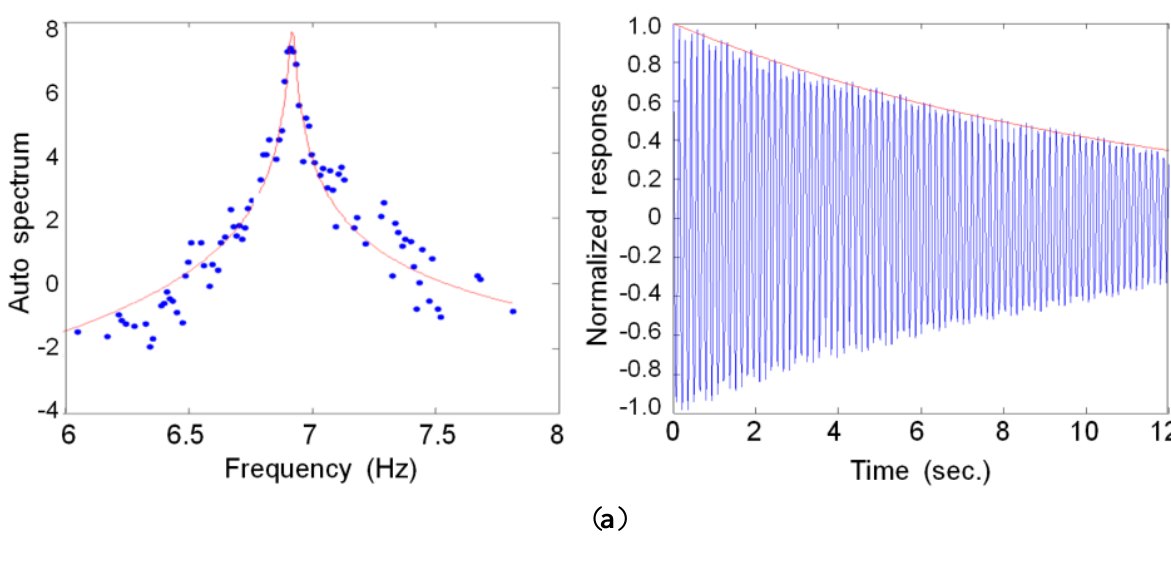
Figure 9. Auto spectrum and free vibration wave for extracting the damping value (1st mode). ( a ) MCS; ( b )